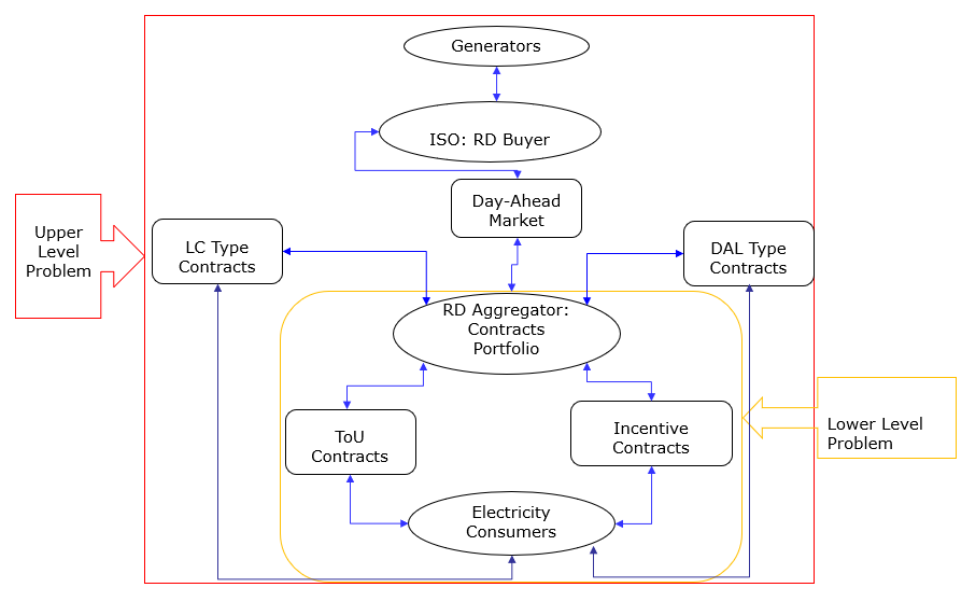
Figure 1. Proposed aggregator Management